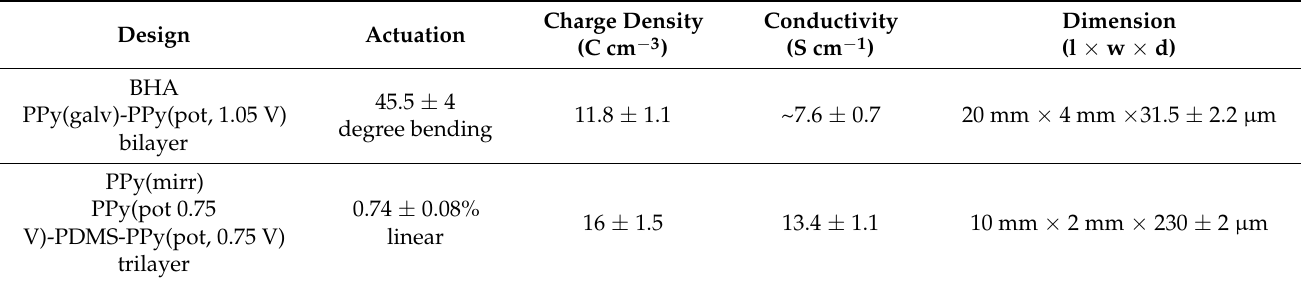
Table 2. Comparison of the main characteristics of BHA and PPy(mirr): actuation behavior, charge density upon oxidation during square wave potential steps from 0 V to1 V at 16.7 mHz, conductivity and dimensions (length l, width w and thickness